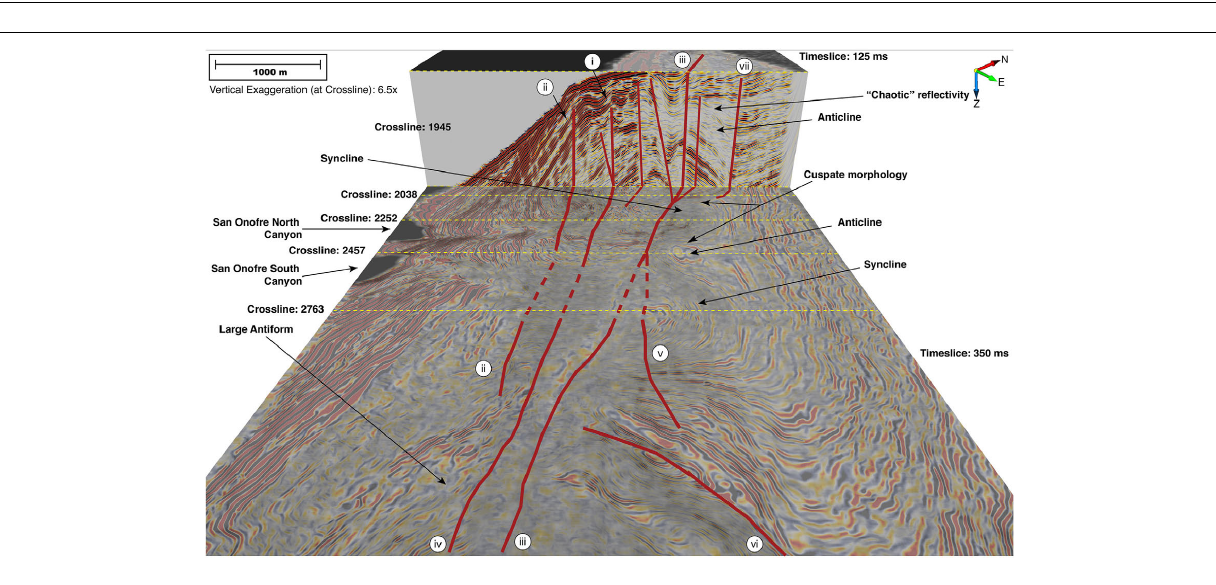
as large embayments just south of the crossline. Farther south ( Figure 8 ), westward dipping reflections are imaged east of fault segment iii and correlate with a circular reflection pattern in the time slice. High amplitude chaotic reflectors are imaged in the upper portions of the crossline with acoustically transparent to chaotic semi-transparent regions beneath ( Figure 8 ).